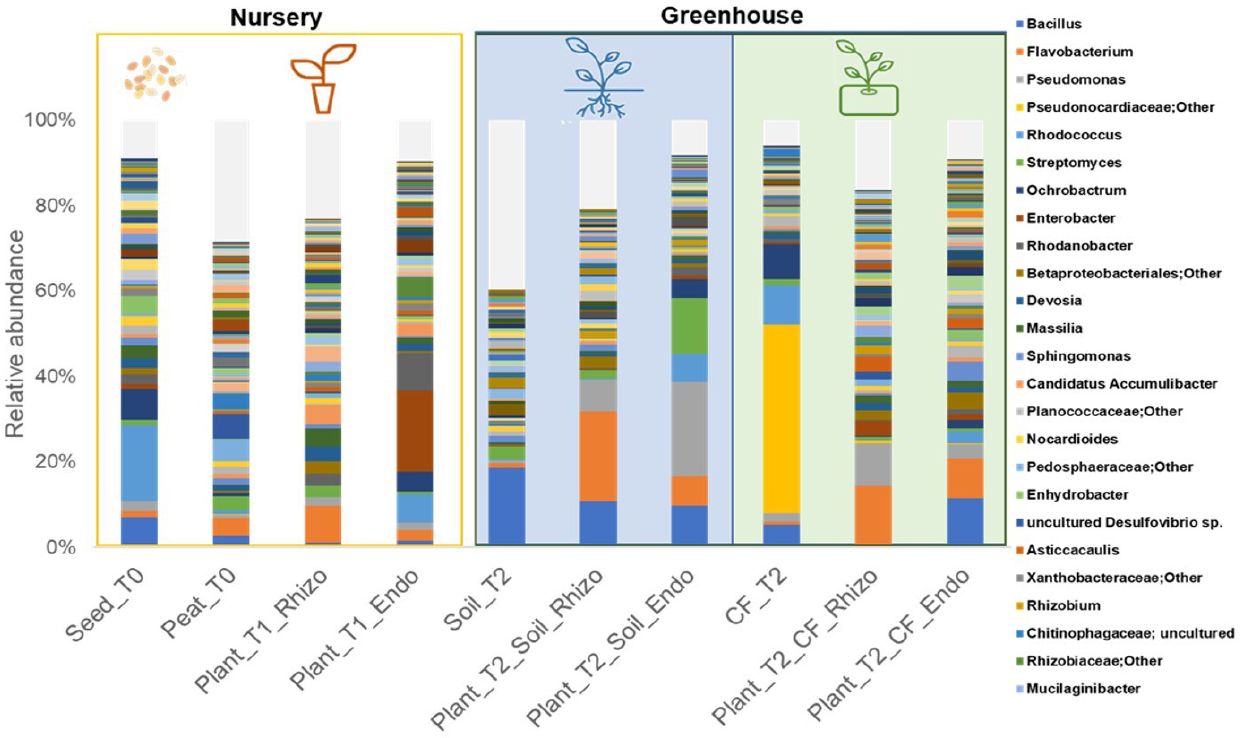
Figure 2. Distribution of bacterial communities in nursery samples, seeds (Seeds_T0), peat sub- strate (Peat_T0) and rhizo and endorhizosphere of plantlets (Plant_T1_Rhizo; Plant_T1_Endo); and greenhouse, coconut fiber substrate (CF_T2) and agricultural soil (Soil_T2), rhizo and endorhizo- sphere of tomato plants in the two cropping systems (Plant_T2_Soil_Rhizo; Plant_T2_CF_Rhizo, Plant_T2_Soil_Endo; Plant_T2_CF_Endo), at the genus level. Bar charts represent bacterial commu- nity composition (only key taxa have been included >1%). The legend refers to the first 25 bacteria depicted at the bottom of the